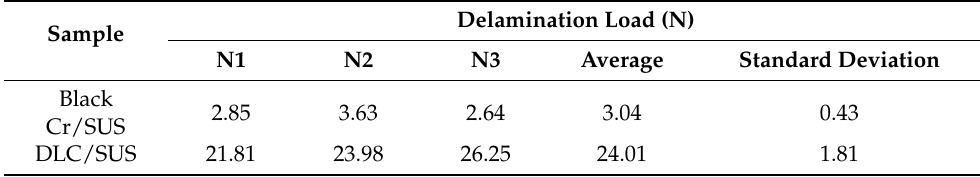
Table 3. Delamination loads of each sample measured in the scratch